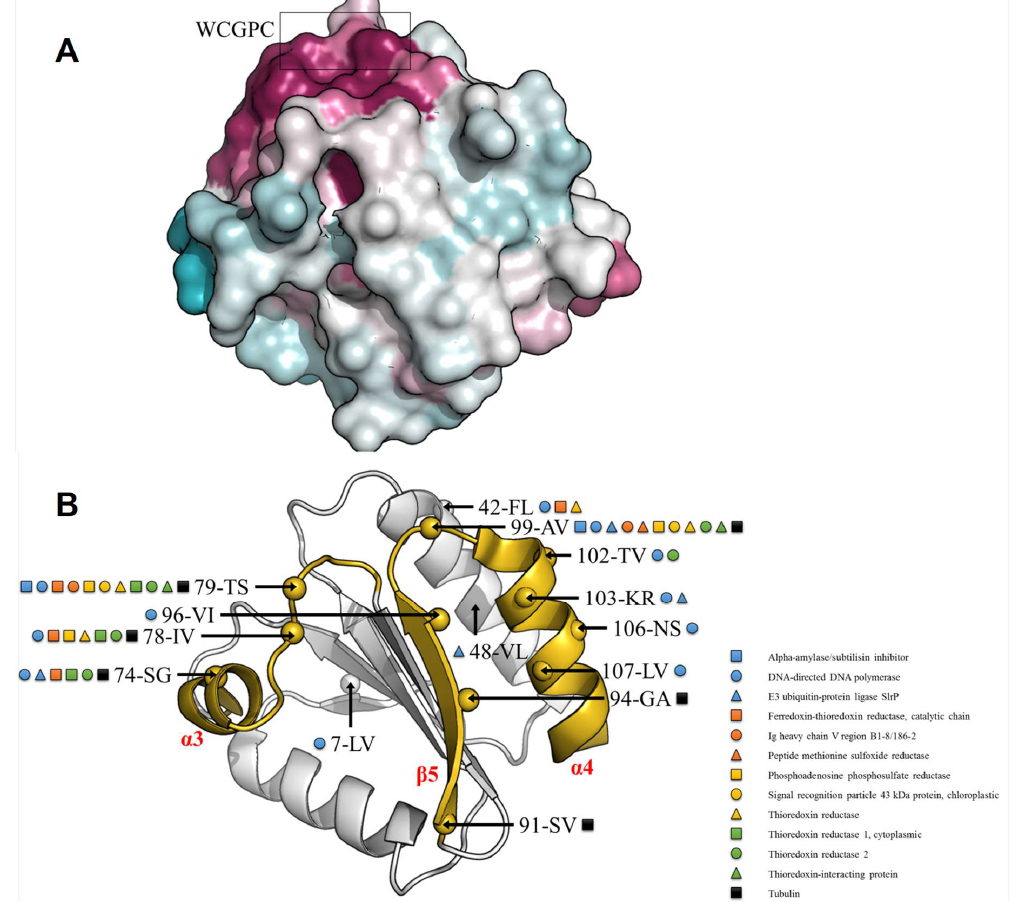
Figure 7. Thioredoxin interfacing residues. ( A ) Residue conservation among 500 thioredoxin orthologs of AtTRXo1 and AtTRXo2 using the ConSurf server [67] with the UniRef90 database (www.uniprot.org/ uniref/). Residues are colored in white to purple, for least to most conserved residues. The conserved WCGPC motif is circled in black. ( B ) AtTRXo1 and AtTRXo2 sequences were blasted against the PDB to find protein–protein interactions involving thioredoxin homologs. 44 complexes were found using an E-Value Cutoff of 0.001. AtTRXo1 and AtTRXo2 non-conserved residues potentially involved in protein–protein interactions were mapped onto the X-ray structure of AtTRXo1. In each case the residue position, and the amino acids in one letter code for AtTRXo1 and AtTRXo2 are shown (ex: 78-IV; position 78, isoleucine and valine found in AtTRXo1 and AtTRXo2, respectively). The area comprising α 3-helix, the loop between α 3 and β 4, β 5-strand, and α 4-helix is colored in